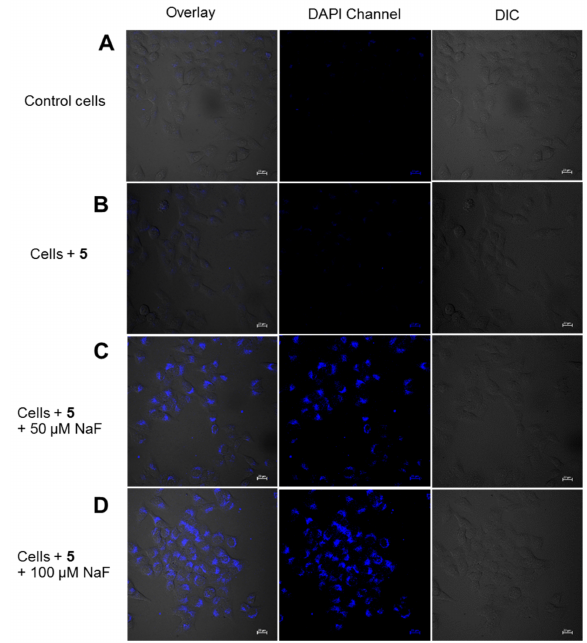
Figure 10. ( A – D ) Confocal laser scanning microscopy (CLSM) images of living HepG2 cells. Panel A, control cells. Panel B, cells incubated with 5 (10 µ M) for 30 min and subsequently 1 h without F − ions. Panel C, cells incubated with 5 (10 µ M) for 30 min and subsequently incubated with NaF (50 µ M) for 1 h. Panel D, cells incubated with 5 (10 µ M) for 30 min and subsequently incubated with NaF (100 µ M) for 1 h (for compound 5 : λ ex = 405 nm, λ em = 450 ± 25 nm, scale bars = 20 µ m). All images were collected at the same microscopy